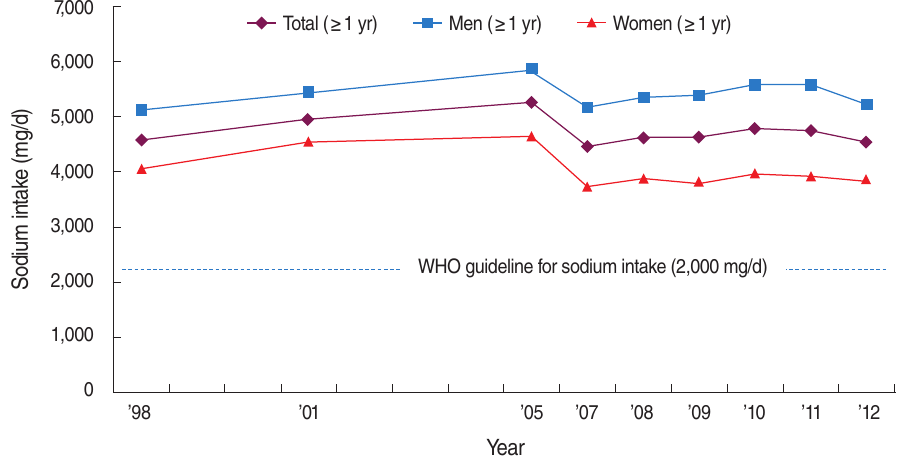
Figure 1. Trend in mean daily intake of sodium among Koreans above 1 year of age, Korea National Health and Nutrition Examination Sur- vey (1998-2012). The age-standardized mean was calculated using an estimated population, based on the 2005 census of the Korean population. Since 2007, a revised food composition table was used to calculate the sodium intake.